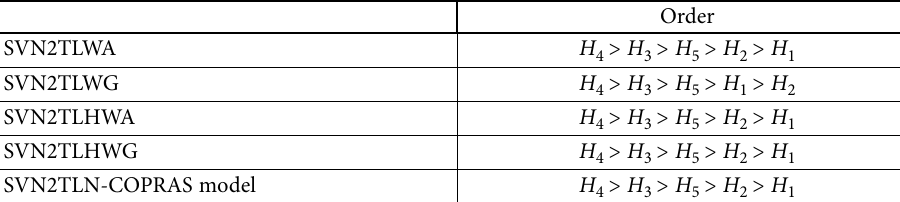
Table 9. The rankings of alternatives deriving from different methods